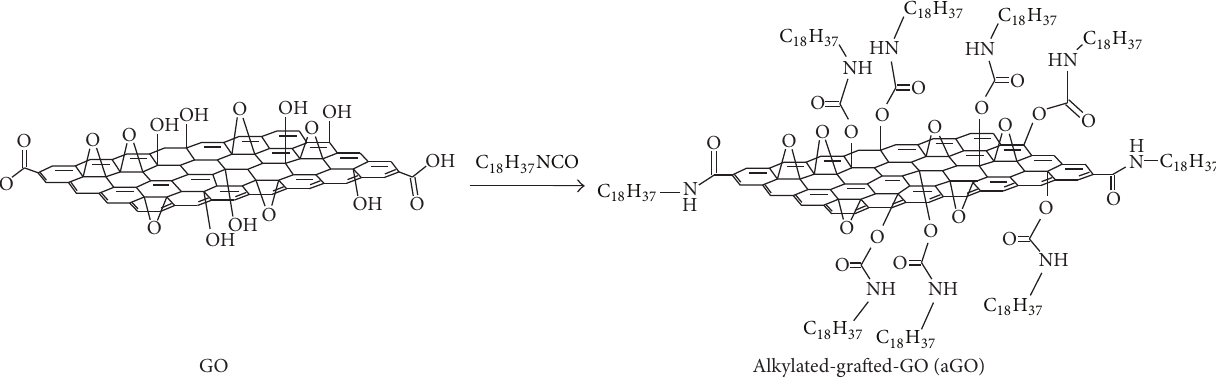
Figure 1: Schematic representation of GO sheets grafted with CH 3 (CH 2 ) 17 NCO.